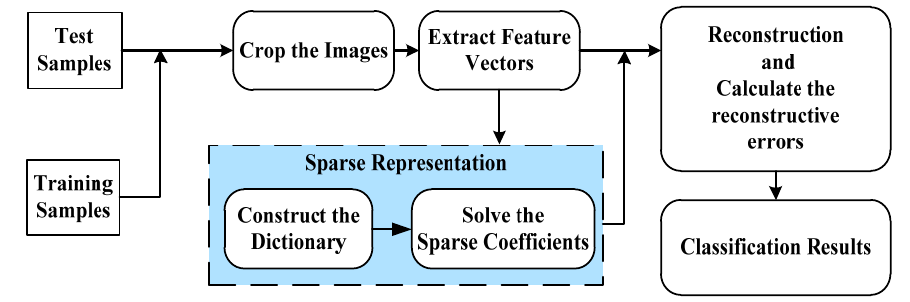
Figure 2. The flow-process diagram of SRC.